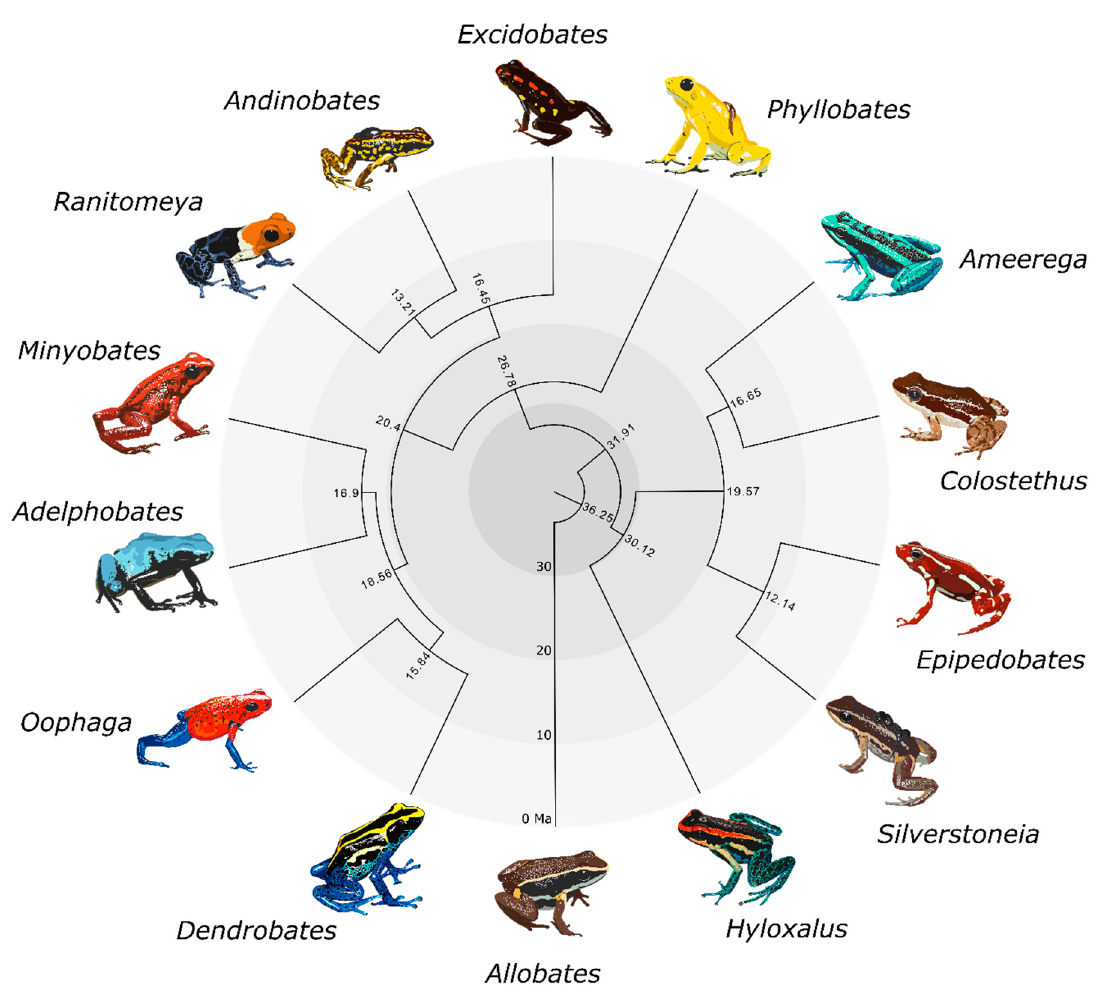
Figure 1. Time-calibrated genus-level phylogeny of Dendrobatidae produced using BEAST. Node labels indicate divergence times (mya). This figure is reduced to one tip per genus from the species-level chronogram in Figure S3. Art by WXG.